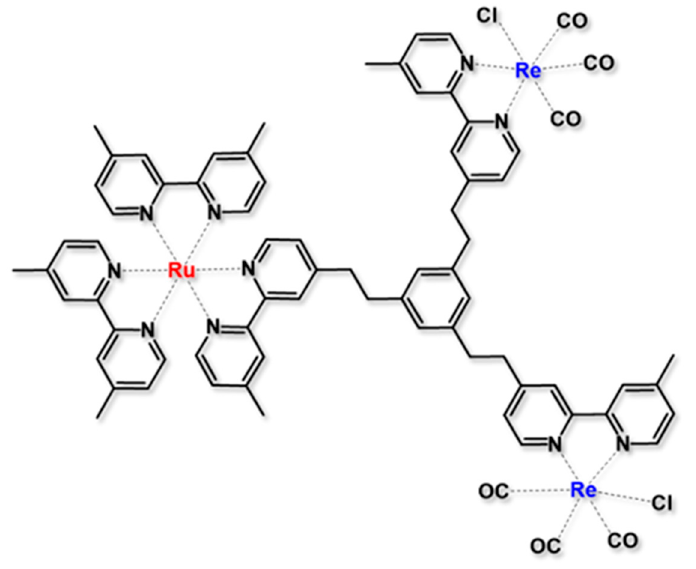
Figure 10. Structure of the supramolecular photocatalyst RuRe 2 for CO 2 reduction [61].